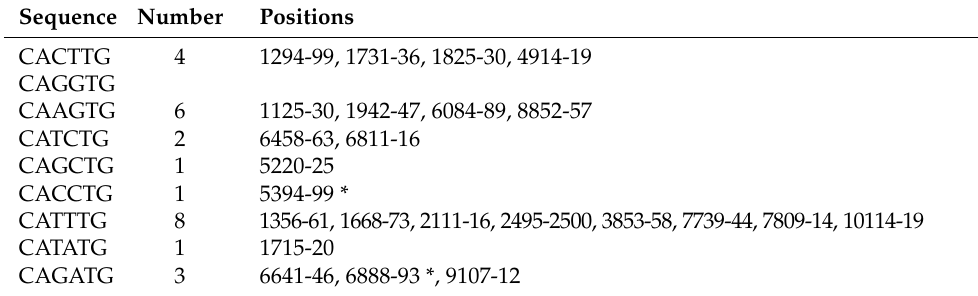
Table 2. The number and positions of E-box hexanucleotide consensus sequence (CANNTG) in BMI1 transcription unit. The asterisks indicate exonic